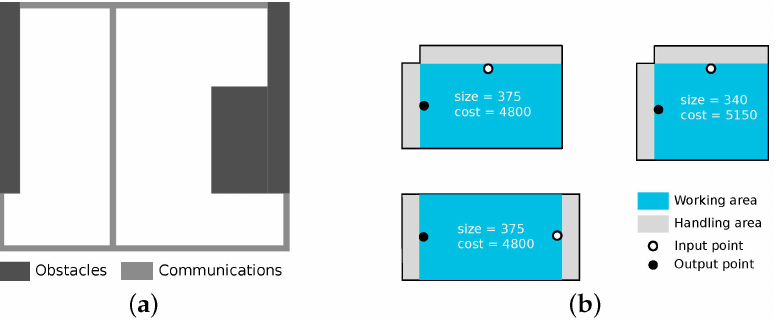
Figure 1. An example of ( a ) the production hall geometry and ( b ) three alternative variants of the same